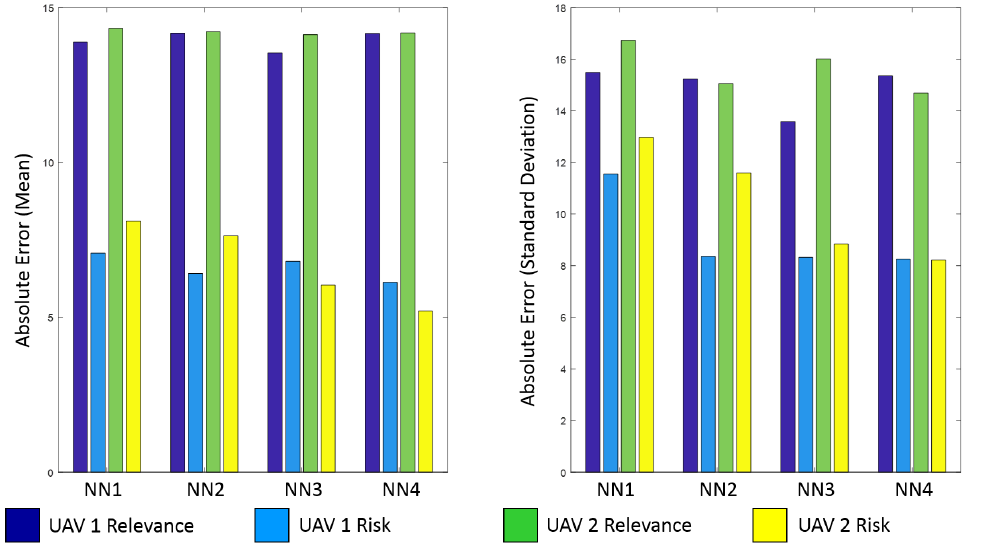
Figure 4. Prediction errors of neural networks.